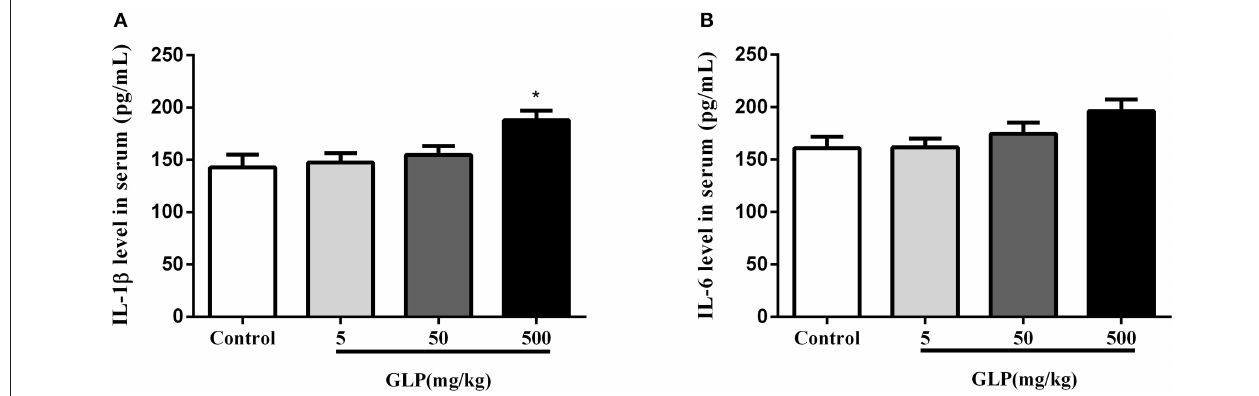
FIGURE 3 | The level of IL-1 β (A) and IL-6 (B) in the serum was assayed by ELISA. Data shown are mean ± SEM of eight animals in each group. Compared to control; * p < 0.05.